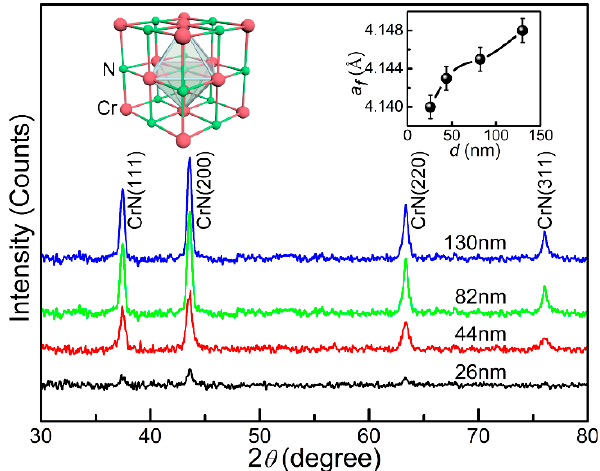
Figure 2. Grazing incidence XRD of CrN thin films with different thicknesses. The crystal structure of CrN and the thickness dependence of lattice constants are shown in the corresponding inset.